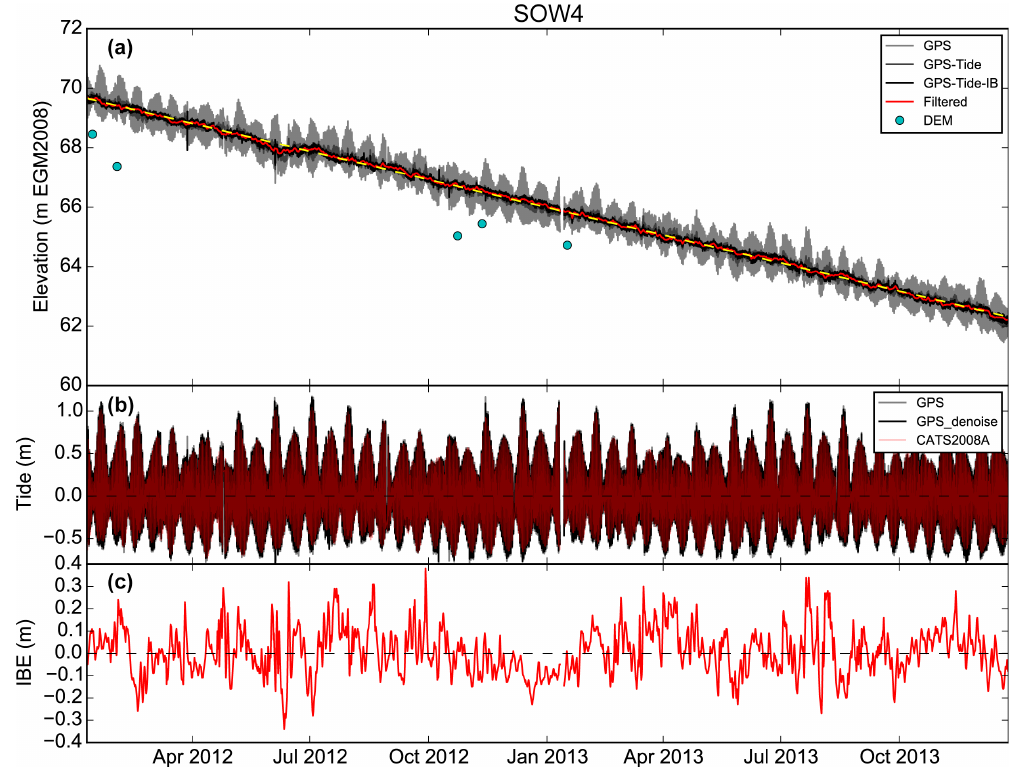
Figure 3. (a) Original GPS antenna elevation (light gray), after tide correction (mid-gray), and after tide + IBE correction (black) for SOW4. The red line shows smoothed time series and the yellow dashed line is linear fit ( − 3.76myr − 1 ). Sampled DEM elevations (cyan) show surface elevation, which is offset from GPS antenna elevation by antenna–surface distance (see Figs. 4 and 8). (b) High-frequency ( < 1.5 days) component of GPS record and CATS2008A tide model prediction, showing excellent agreement. (c) Estimated inverse barometer effect (IBE) magnitude from scaled sea level